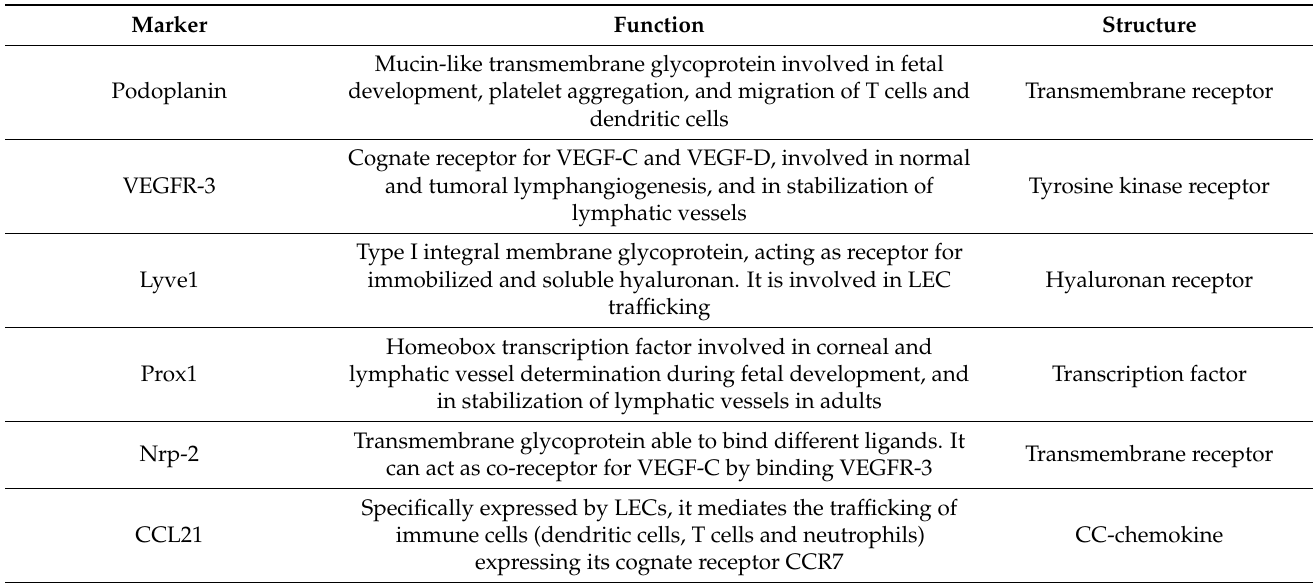
Table 1. Specific phenotypic markers of lymphatic